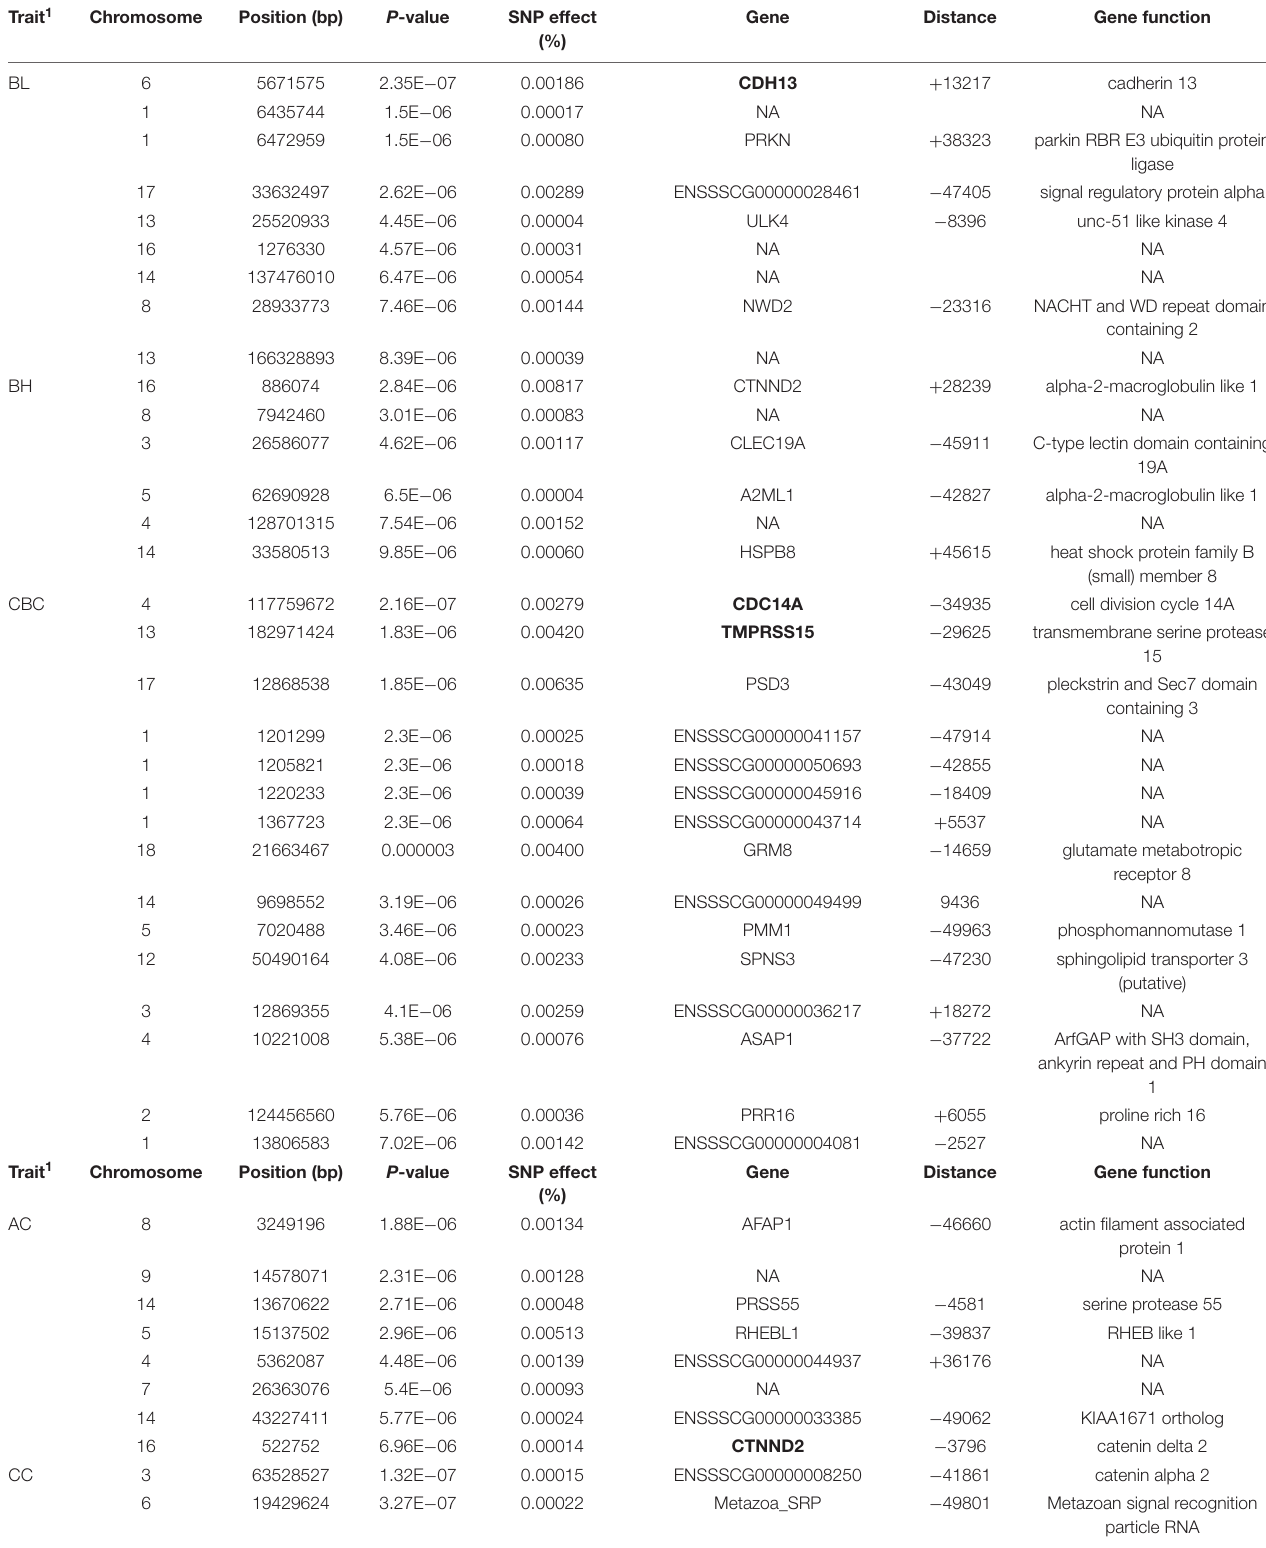
TABLE 3 | Significant SNPs and associated genes for seven body size traits. Trait